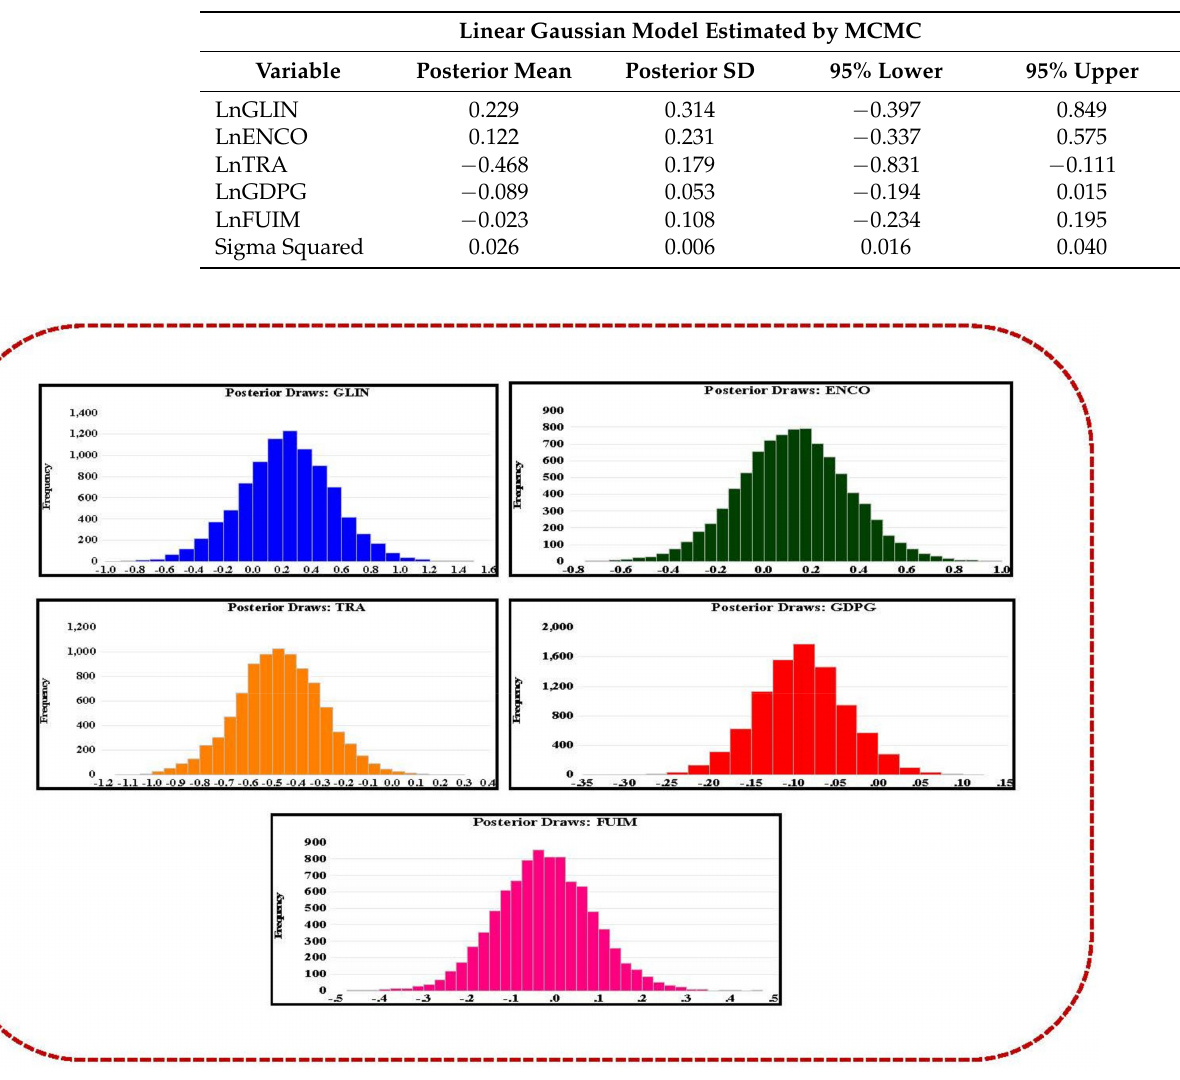
Figure 3. Plots of the posterior draws via linear Gaussian